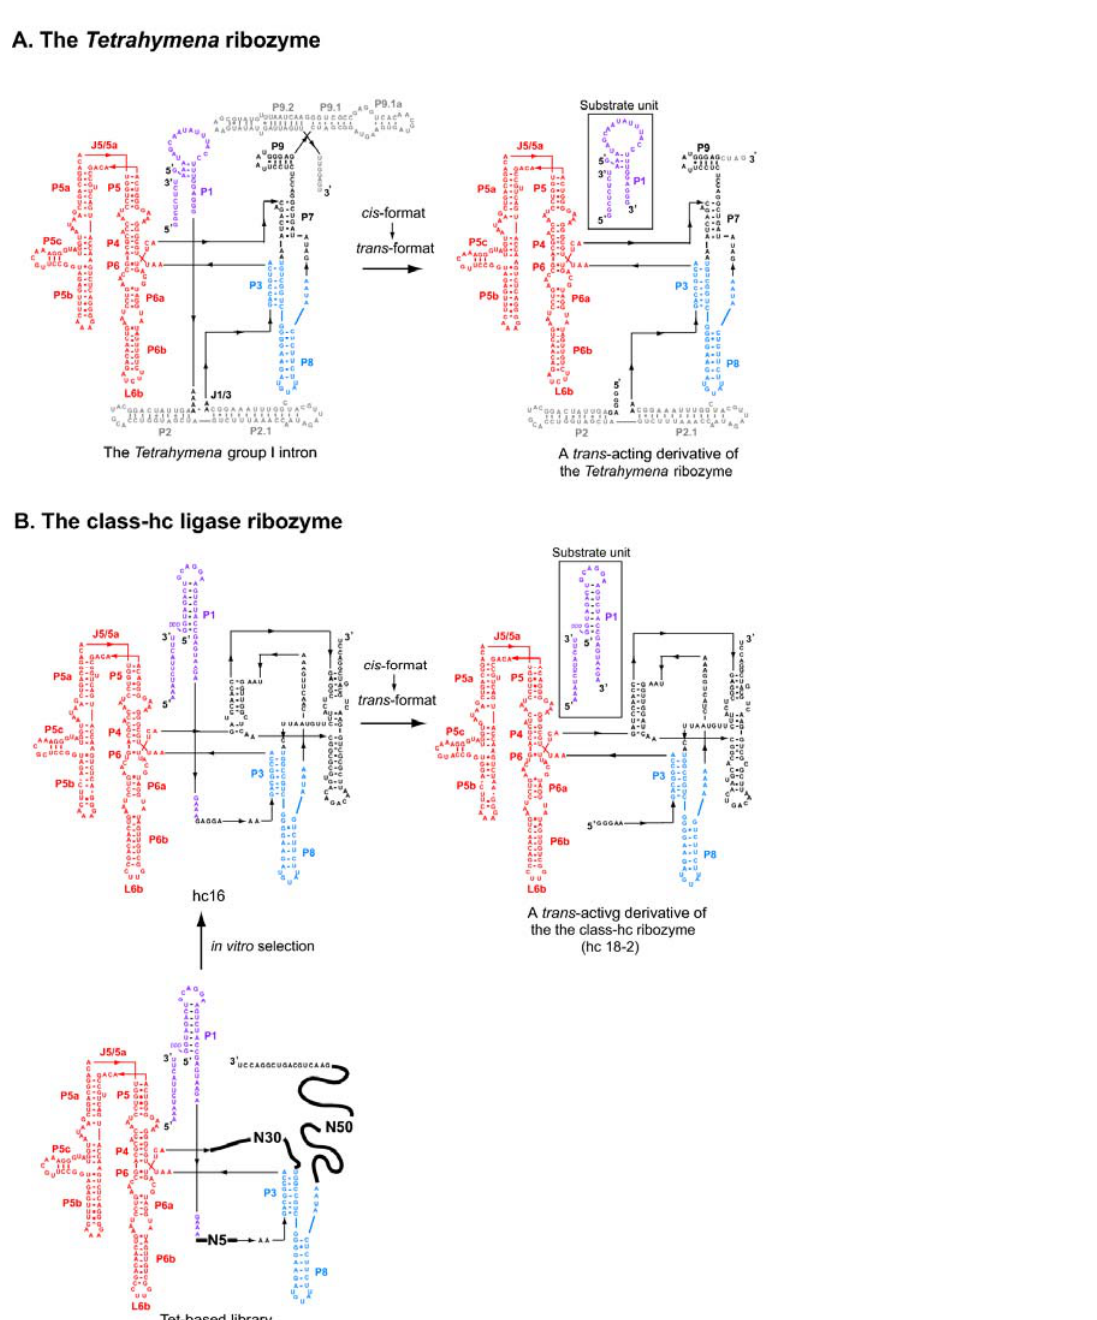
Figure 3. Modular architecture of the Tetrahymena ribozyme and the class-hc ligase ribozyme. (A) The modular architecture of the Tetrahymena group I ribozyme (left) and its trans -acting derivative (right). The P4-P6 domain and the substrate P1 element are shown in red and purple, respectively. The elements commonly used in the class-hc ligase ribozyme are shown in blue. (B) The modular architecture of a library (lower left), an isolated clone (hc 16, upper left), and a trans -acting derivative (hc 18-2, upper right) of the class-hc ligase ribozyme. The P4-P6 domain and the substrate P1 element are shown in red and purple, respectively. The elements commonly used in the Tetrahymena ribozyme are shown in